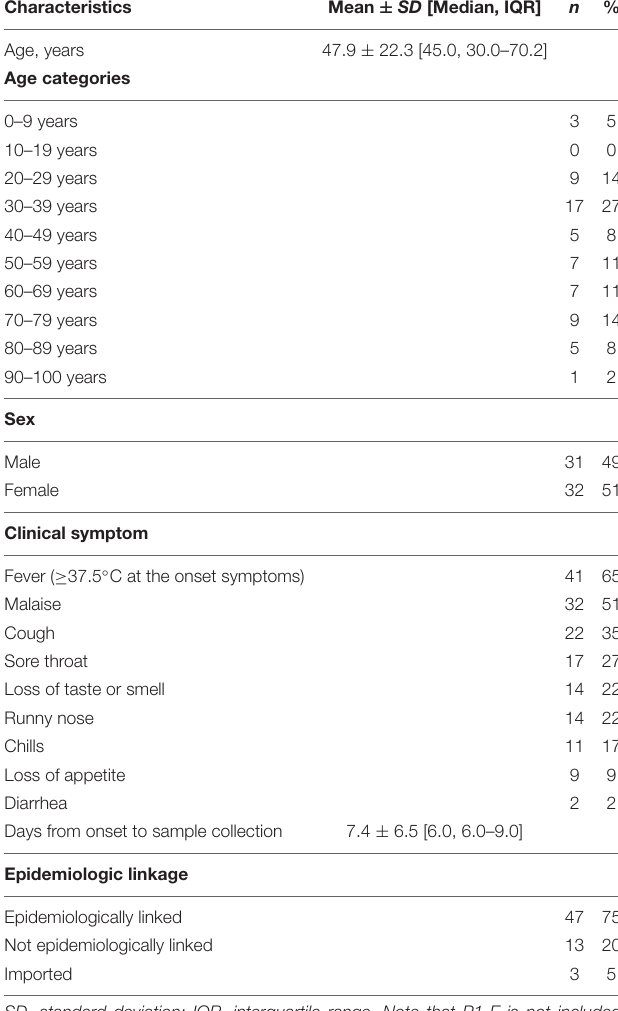
TABLE 1 | Epidemiological characteristics of patients with COVID-19 in Niigata City, Japan between February and May 2020 ( n = 63).